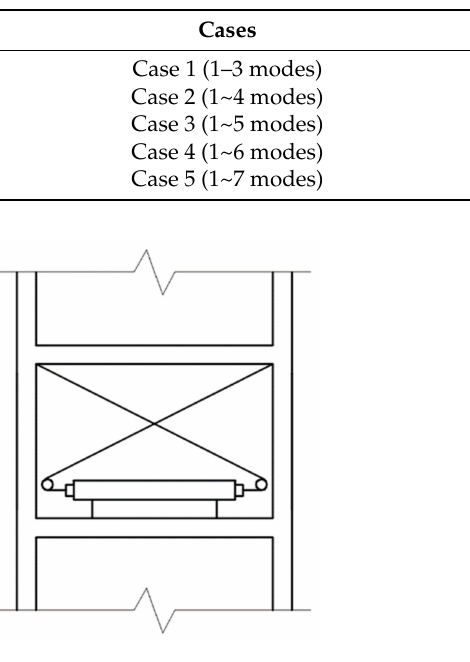
Figure 3. Actuator with horizontal placement. Table 4. Weight adjustment coefficients in Case